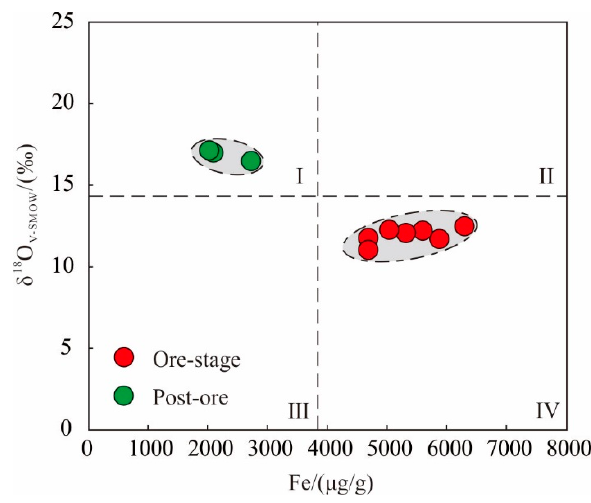
Figure 11. Fe contents vs. δ 18 O V-SMOW value plot for calcites from the Zhesang gold deposit. I, II, III = non-prospecting area; IV = prospecting area. Minerals 2019 , 9 , x FOR PEER REVIEW